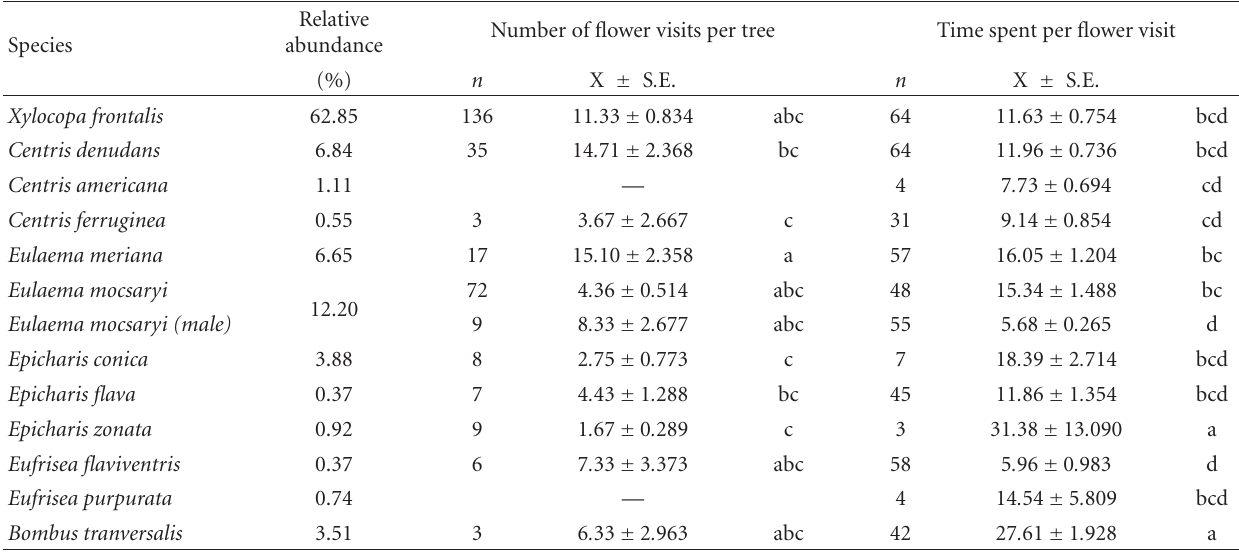
Table 3: Bee relative abundance, mean number ( ± standard error: SE) of flowers visited per tree by ten bee species and mean time ( ± standard error: SE), in seconds, spent by twelve bee species per visit to flowers of Brazil nut ( Bertholletia excelsa ) variety 609, under cultivation in the Amazon rainforest ( n : number of bees recorded per